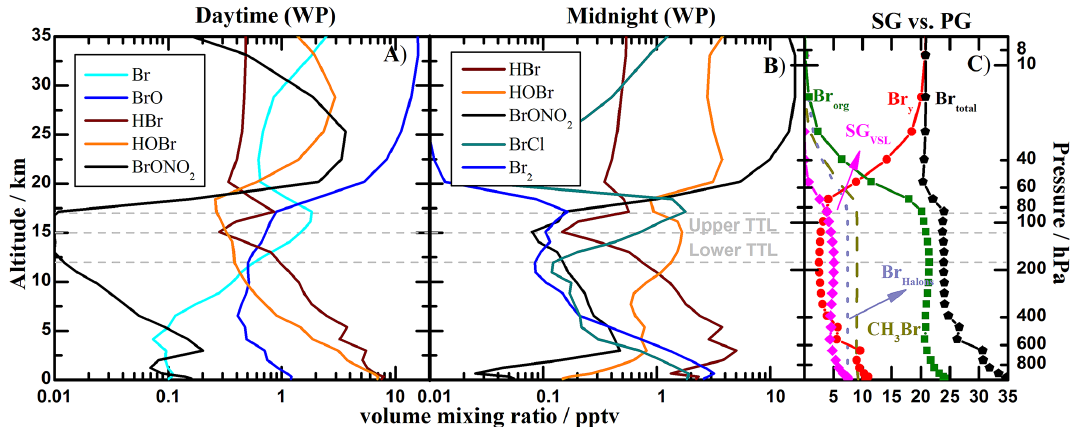
Figure 11. Vertical profile abundances of organic and inorganic bromine species within the WP region during February: (a) main Br y species at noon; (b) main Br y species at midnight; and (c) 24h average contribution of organic and inorganic species to total